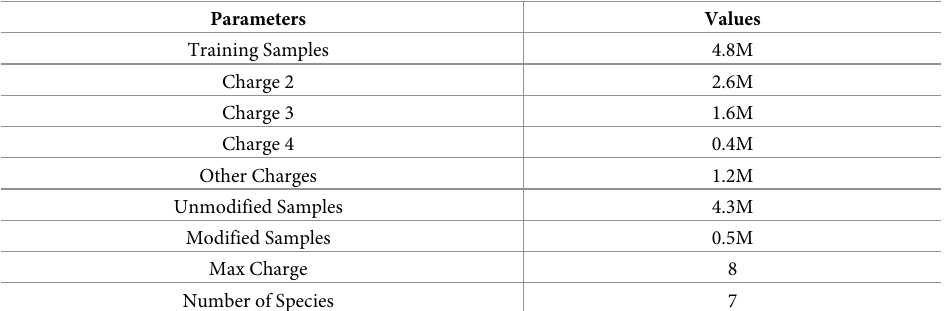
Table 2. Characteristics of training dataset used. Data was acquired from online repositories including NIST peptide library, MassIVE. The post translation modification in the dataset are CAM, Phosphorylation, Oxidation, and N-termi- nal Acetylation.